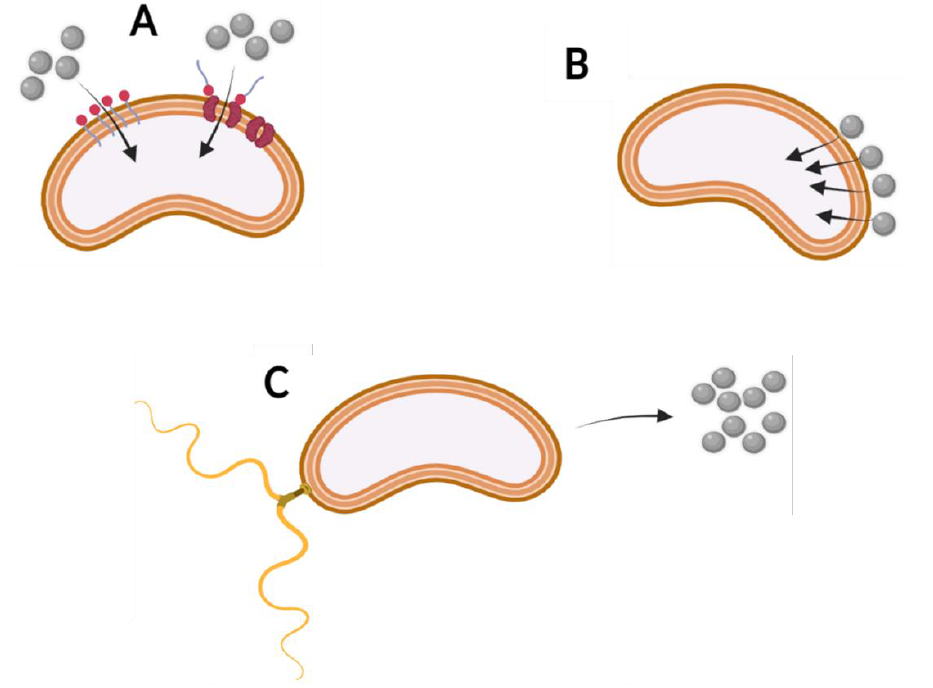
Figure 4. Main strategies of increasing bioavailability of organic compounds (grey circles) at the microbiological level: ( A ) cell membrane modification, e.g., with surfactant; ( B ) organic compound adsorption on the cell surface; ( C ) chemotaxis towards chemicals.